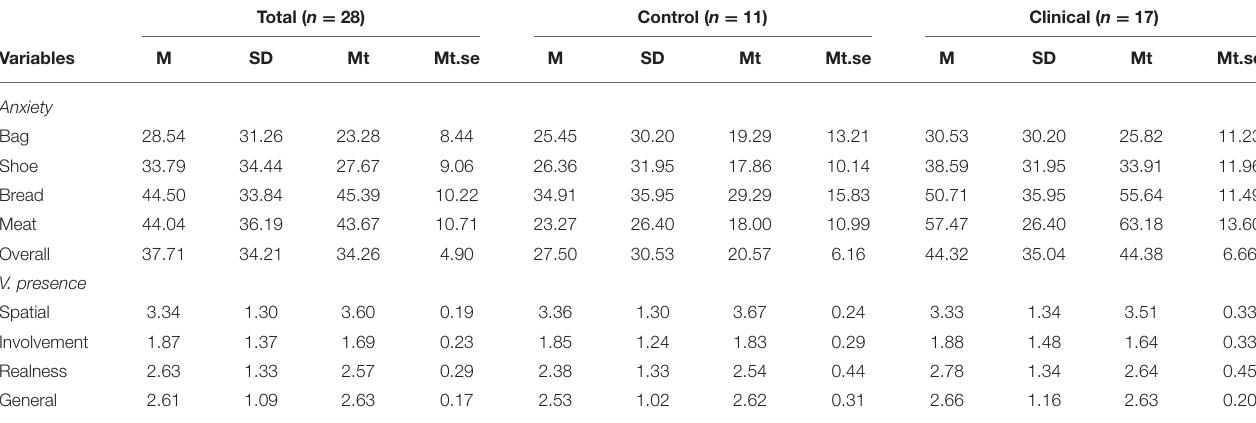
TABLE 1 | Descriptive statistics for the anxiety and virtual presence